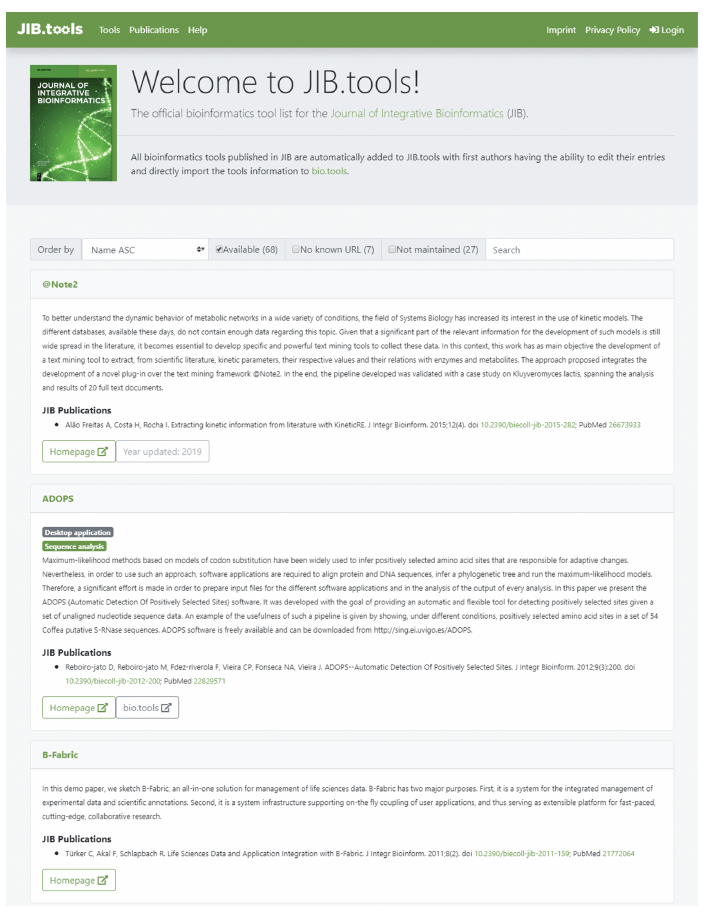
Figure 4: JIB.tools 2.0: the entry page of JIB.tools providing different filtering options and a search